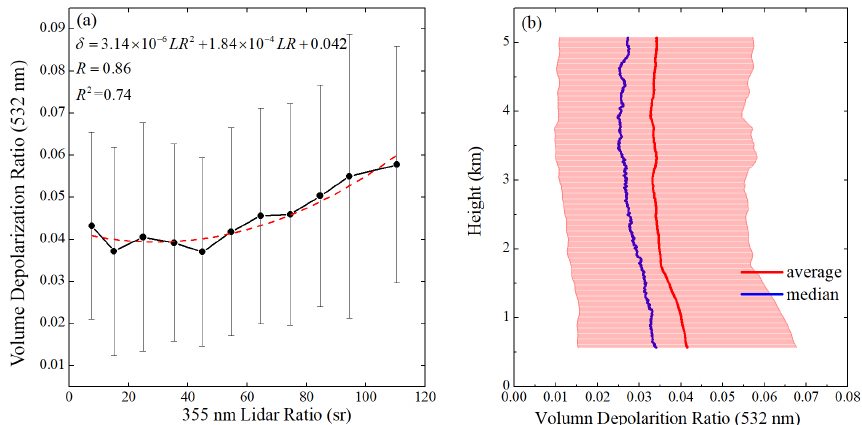
Figure 6. Effect of δ on LR. (a) LR was divided into 11 intervals and the mean value of δ in each interval was calculated. The dot and error bar represent the mean and standard deviation of δ in each interval. The red dotted line is the fitting line of LR and δ . (b) The red line is the mean profile of δ , the blue line is the median profile of δ , and the red shadow is the error bar, meaning the standard deviation.